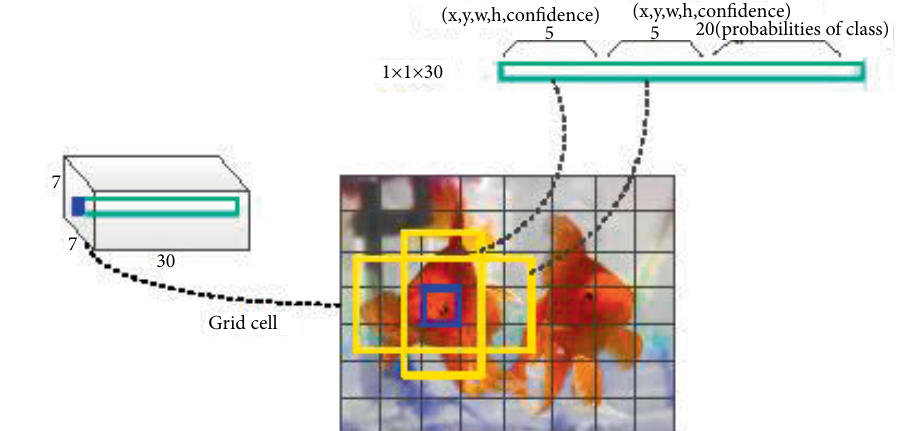
Figure 8: Output of CNN model using ImageNET.